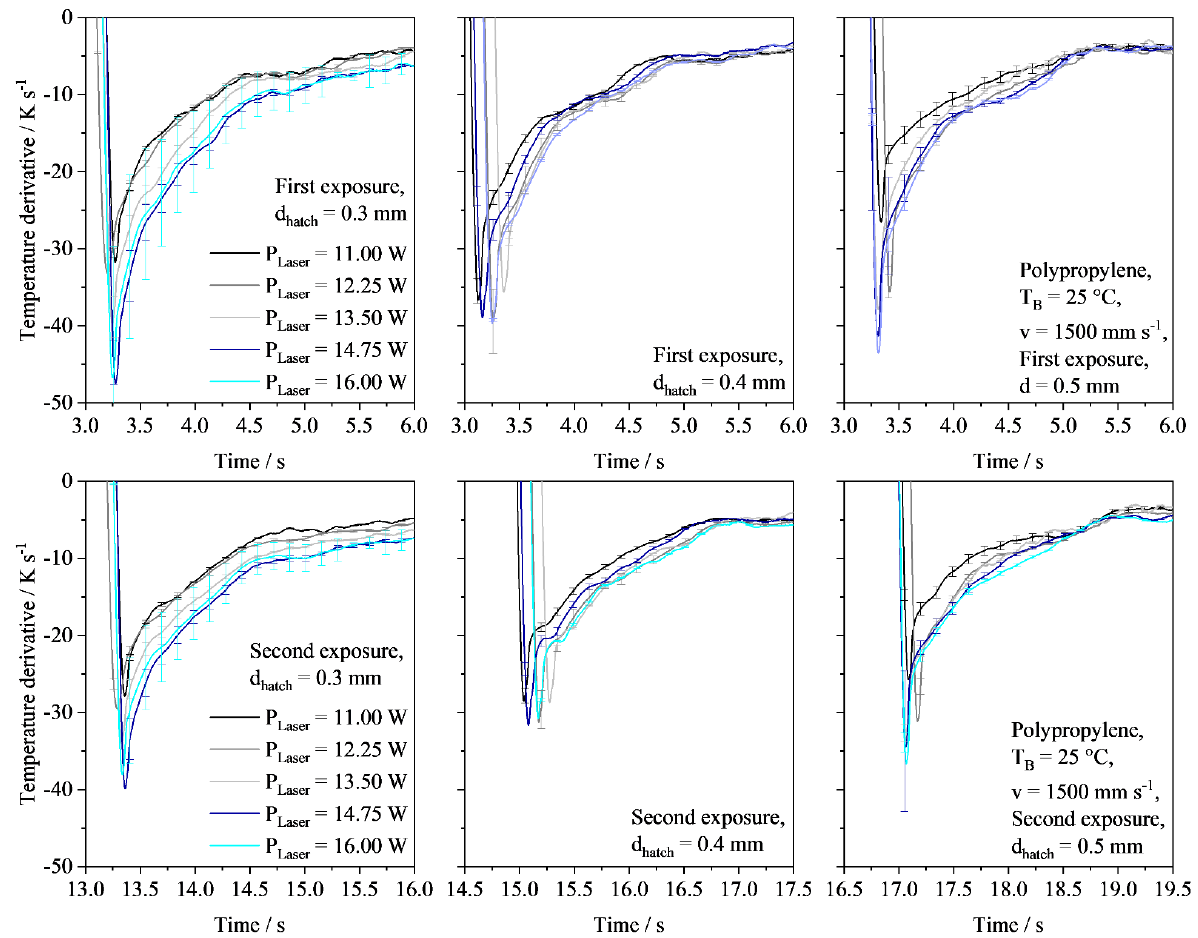
Figure 7. Influence of varied process parameters and geometric boundary conditions on resulting transient cooling rates. transient cooling